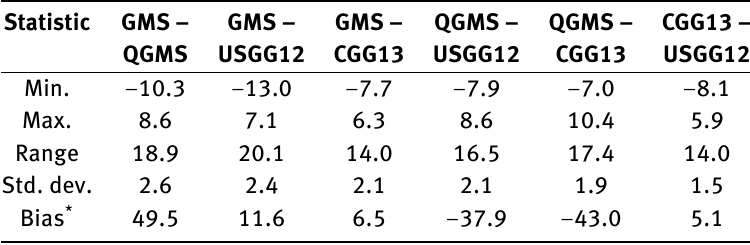
Table 9: Statistics of the differences between the different geoids for the New Hampshire test area. Unit is in cm